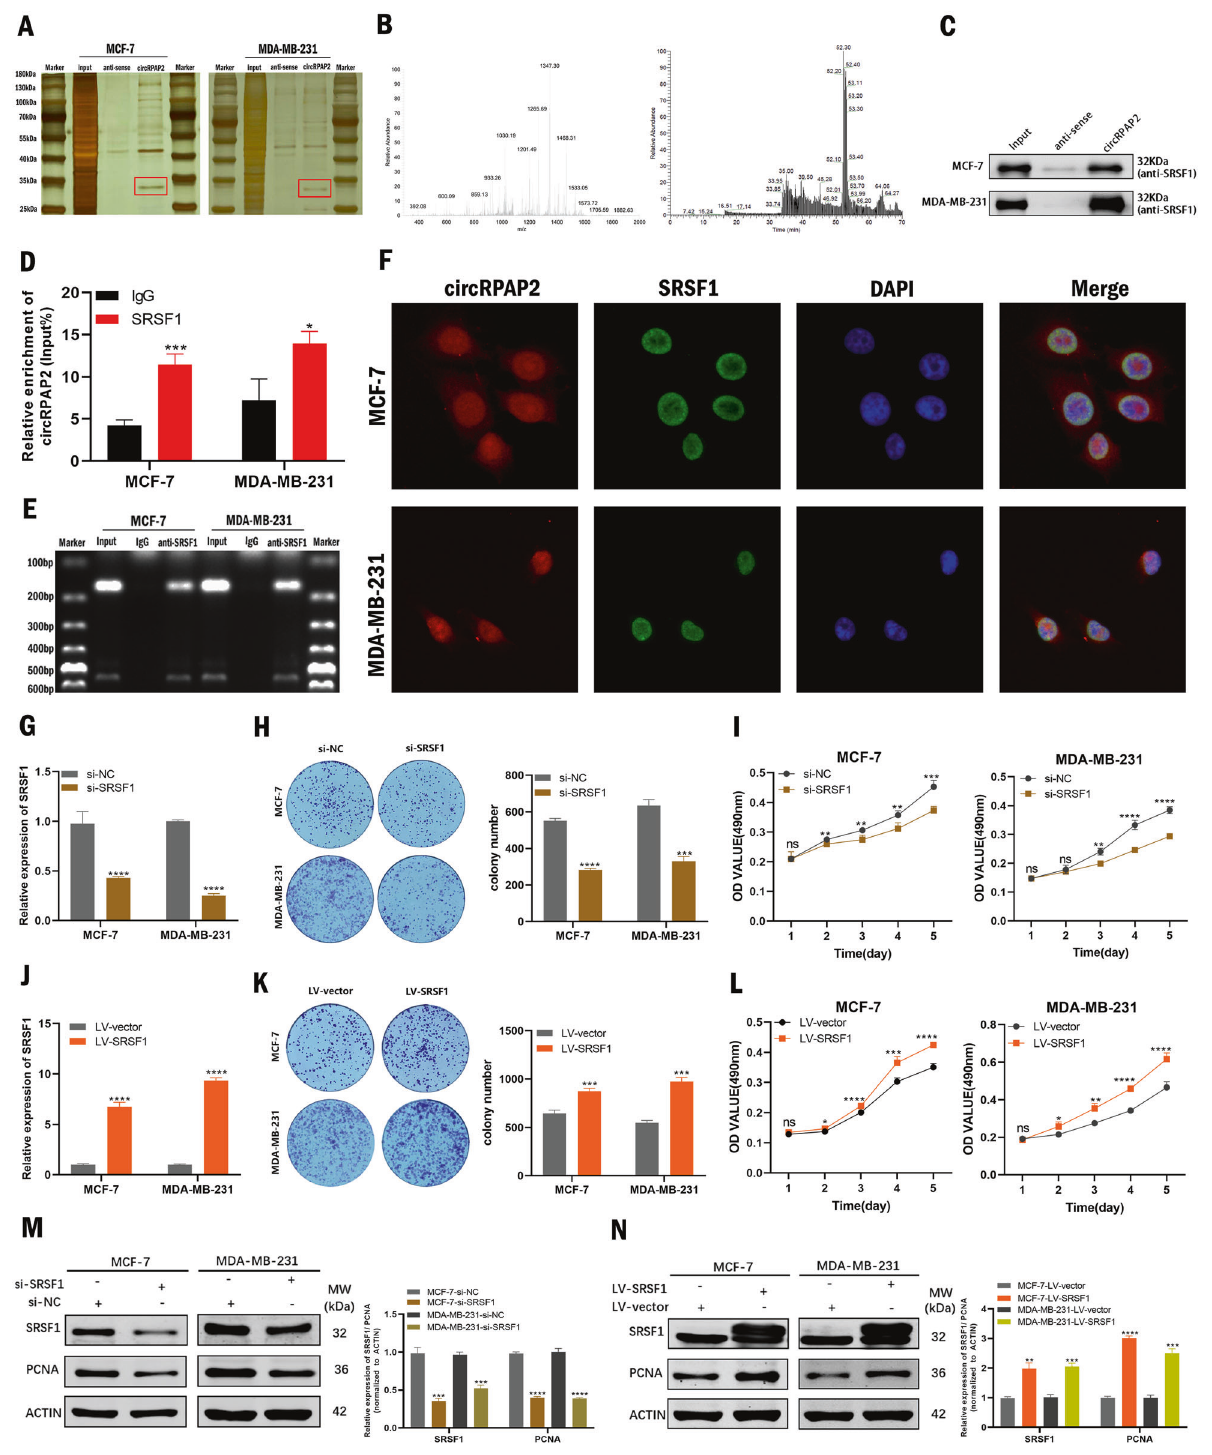
Fig. 3 CircRPAP2 binds to the oncoprotein SRSF1 in the nucleus. A Silver staining of circRPAP2 pulldown products. Red squares indicate bands differing between the sense and anti-sense lanes. B Protein mass spectrometry analysis of the different bands. C – E Results of RNA pulldown and RIP assays to identify binding between circRPAP2 and SRSF1. F Combination of FISH and IF assays indicates circRPAP2 and SRSF1 are co-localized, mainly in the cell nucleus. G and J Relative expression of SRSF1 was con fi rmed by qRT-PCR in BC cells transfected with si-NC, si- SRSF1 ( G ), LV – vector, or LV-SRSF1 ( J ). H and K Effect of si-SRSF1 ( H ) and LV-SRSF1 ( K ) on BC cell proliferation as determined by colony formation assays. I and L Effect of si-SRSF1 ( I ) and LV-SRSF1 ( L ) on BC cell proliferation as determined by MTT assays. M and N Effect of si-SRSF1 ( M ) and LV- SRSF1 ( N ) on BC cell proliferation in BC cells as determined by western blotting. (* P < 0.05, ** P < 0.01, *** P < 0.001, **** P < 0.0001).